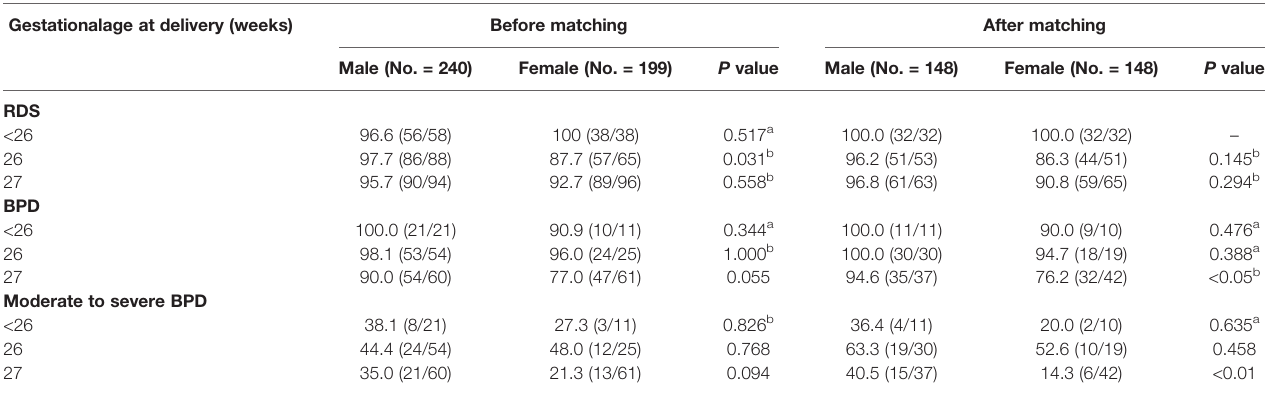
TABLE 3 | The effects of gestational age on the incidence of respiratory complications in male and female EPIs (%[diagnosed No./assessed No.]). Gestationalage at delivery (weeks) Before matching